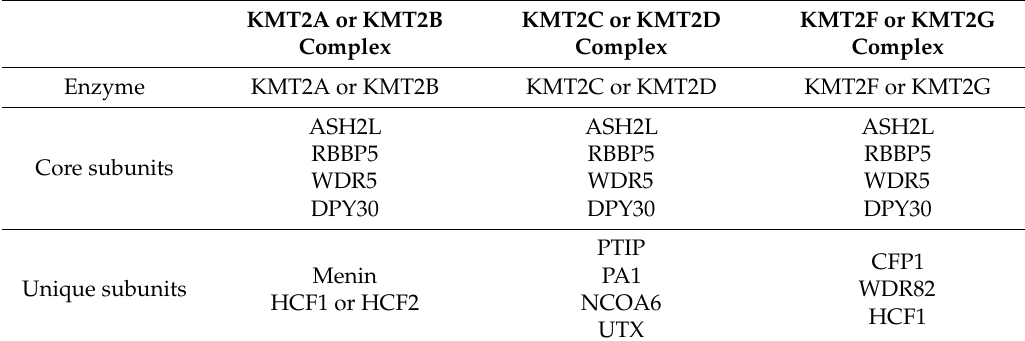
Table 1. Subunit composition of the mammalian KMT2